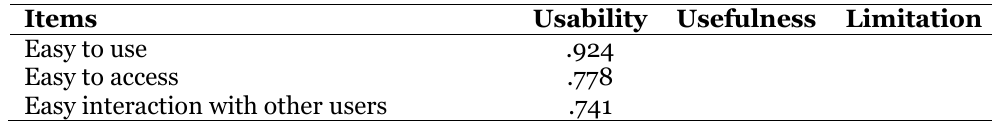
PLE Perception Scale Principal Axis Factoring Item